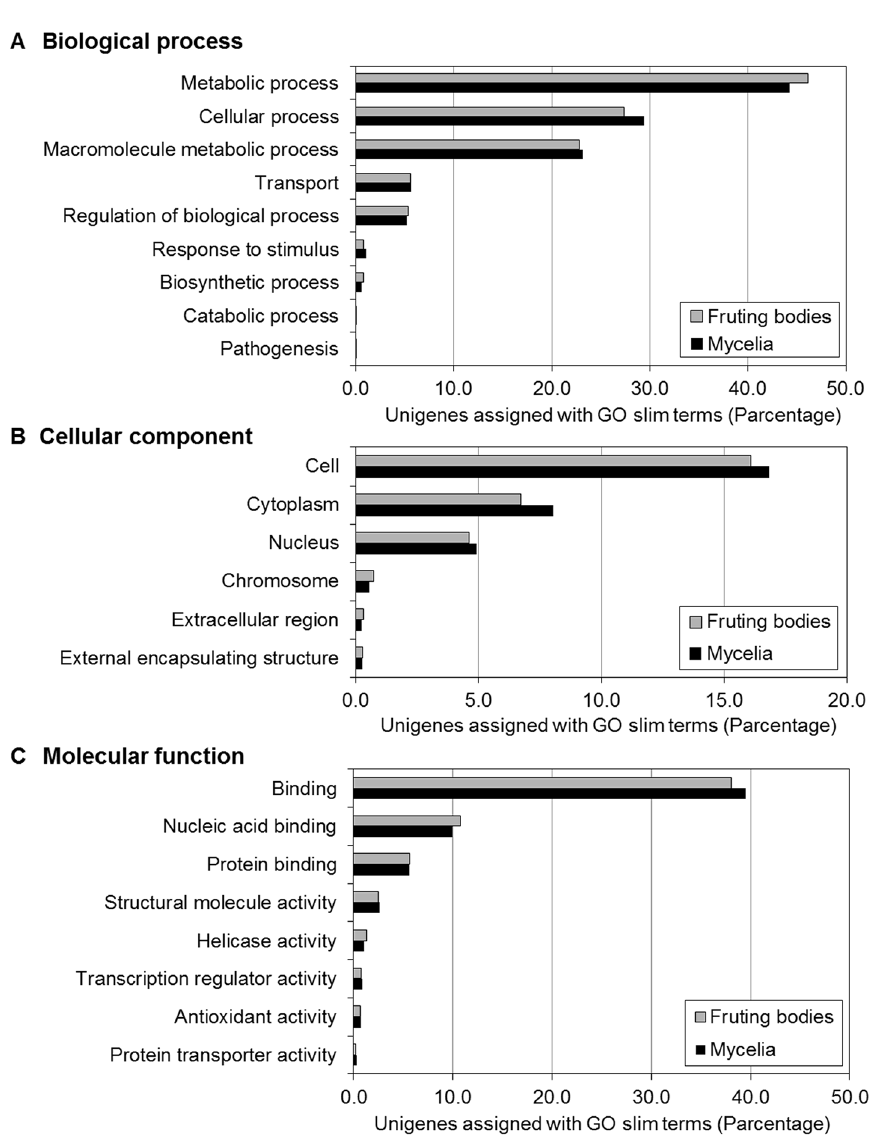
Figure 2. Distributions of GO slim terms assigned to the unigenes. (A) Biological process, (B) cellular component, (C) molecular